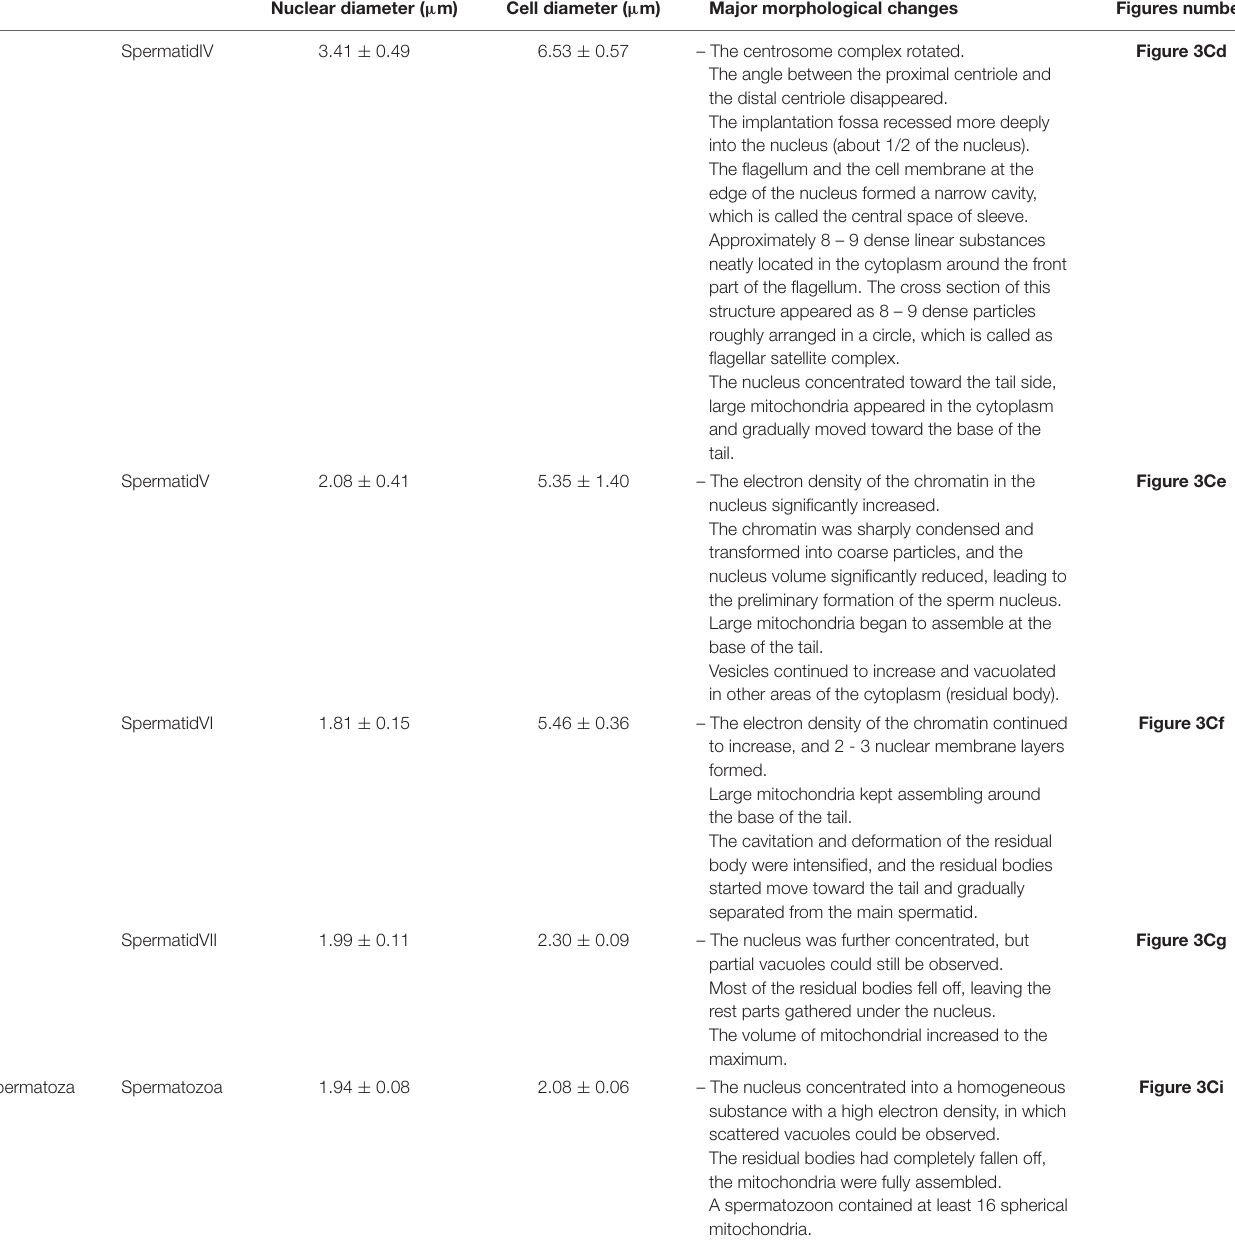
( Figure 6Ac ). Compared to the 11-KT, the content of T increased at the stages of IV(2200 g) and V(2500 g) before falling back to the initial level ( Figure 6Ad ). The concentration of 17 α ,20 β -DHP was high during the stage of II(15 g) and the mature stages from V(2500 g) to VI(2500 g). Moreover, the content of P4 exhibited a similar trend as that of 17 α ,20 β -DHP, with a high level at the stage of II(15 g), II(400 g), and V(2500 g) ( Figure 6Ae ). During the mature stages from IV(2200 g) to V(2500 g), the serum concentrations of T3, 5- HT, T, 17 α ,20 β -DHP and E2 all increased, and the